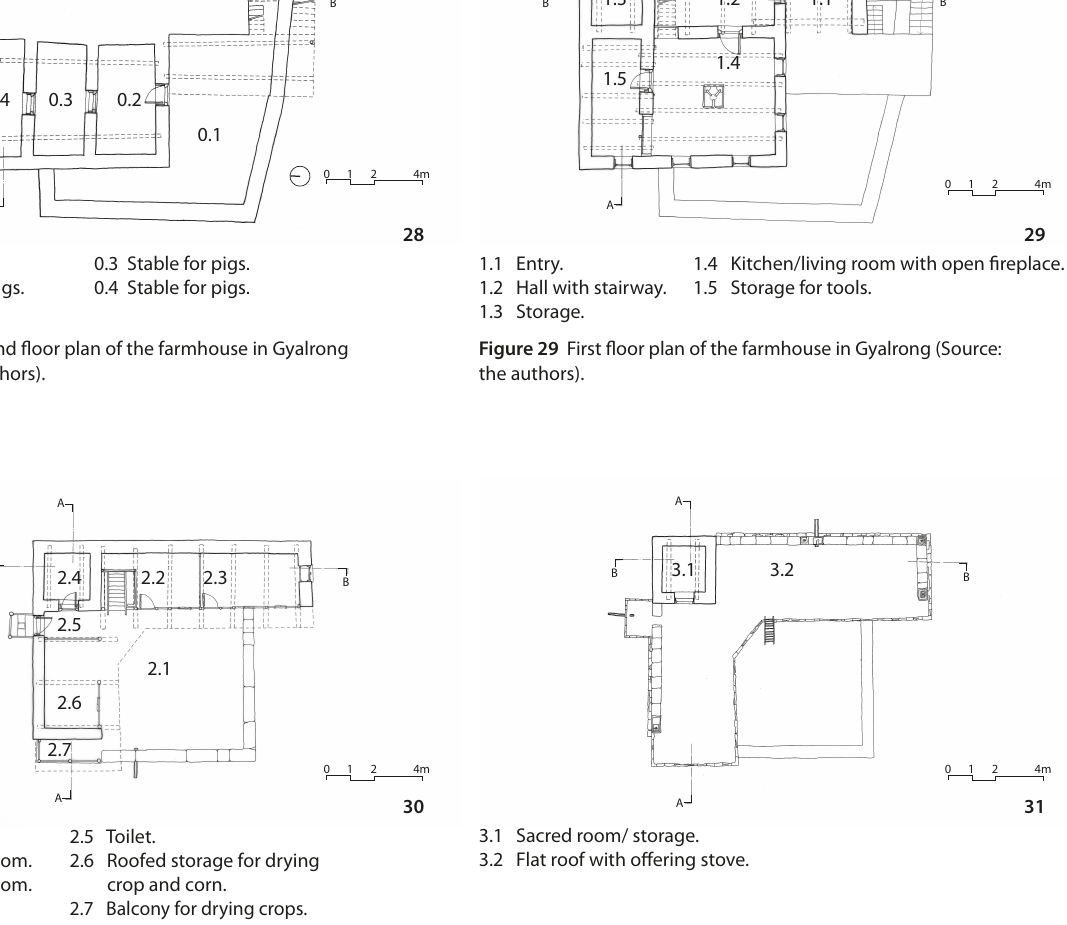
Figure 30 Second floor plan of the farmhouse in Gyalrong (Source: the authors).